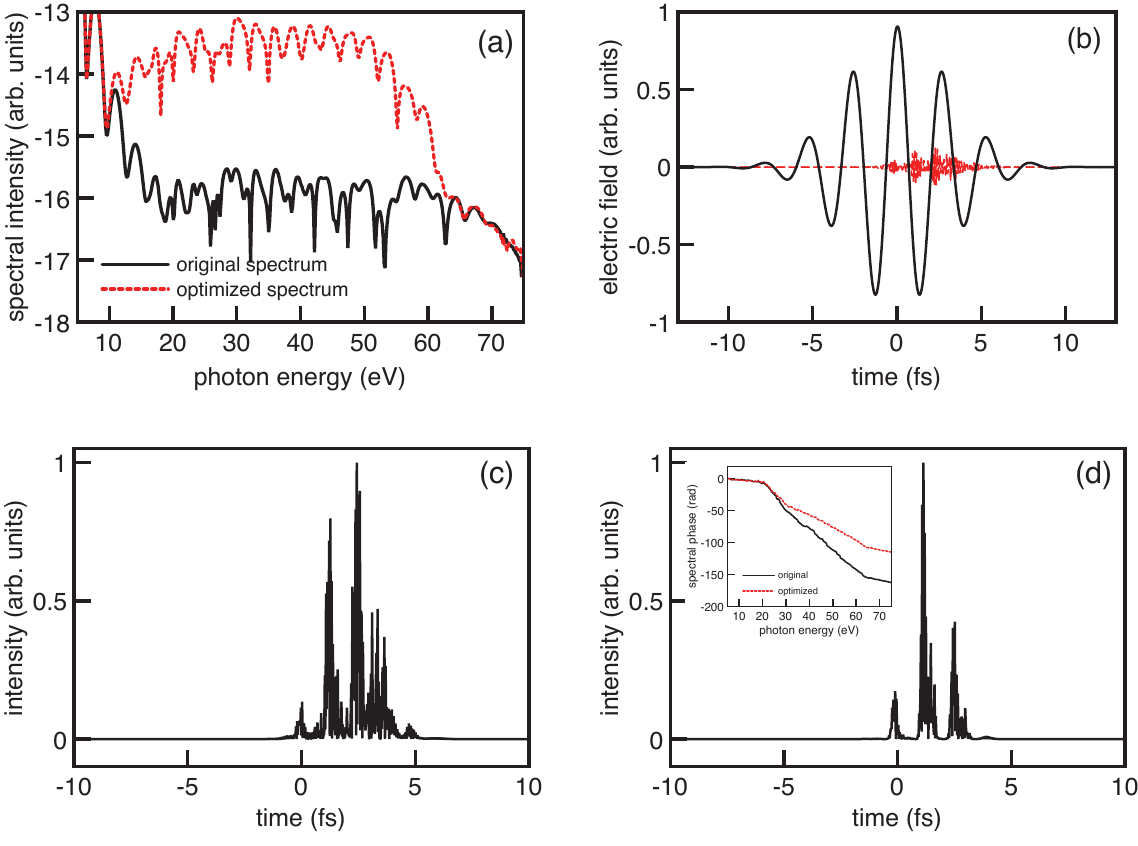
Figure 4. (Color online) Optimization of the HHG spectral region 21–51 eV obtained by considering a single feedback loop. The scan in (cid:18) is from (cid:18) = − 180 ◦ to (cid:18) = 180 ◦ , and (cid:11) is fixed to 10 7 . The value of the normalized (cid:31) 2 function is 0.9998 for the original spectrum and 0.9893 for the optimized one. In ( a ) the spectral intensity of the original and optimized spectra are shown, as indicated. The IR driving pulse together with the optimal XUV pulse are shown in ( b ). The amplitude of the IR pulse is normalized, and the one corresponding to the XUV pulse has been rescaled to allow its visualization. The optimal value for the angular position results in (cid:18) = − 22 ◦ . ( c ) and ( d ) show the temporal evolution of the intensities of the XUV pulses resulting from the second interaction region, before and after optimization, respectively, which are centered at a photon energy of 36 eV. The inset in ( d ) shows the spectral phase for the original and optimized spectra. Note that the labels in the vertical axis of ( a ) indicate a logarithmic